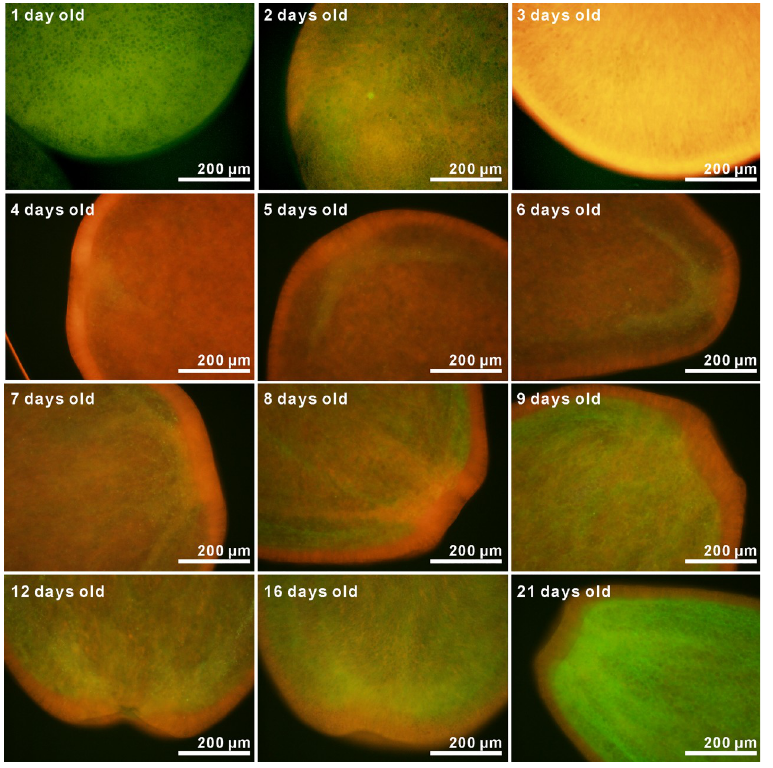
Fig 3. Fluorescent micrographs of A . tenuis larvae taken under blue-violet excitation (Ex. 400–440 nm, Em. � 475 nm). Micrographs of one to three-day-old larvae were taken with an exposure time of 500 ms, whereas those for four- day-old or older larvae were taken with an exposure time of 50 ms and without any digital black balances. Although micrographs for one to three-day-old larvae had a slightly different color than those for four-day-old or older larvae, changes in larval fluorescence at four- to 21-days-old could be confirmed